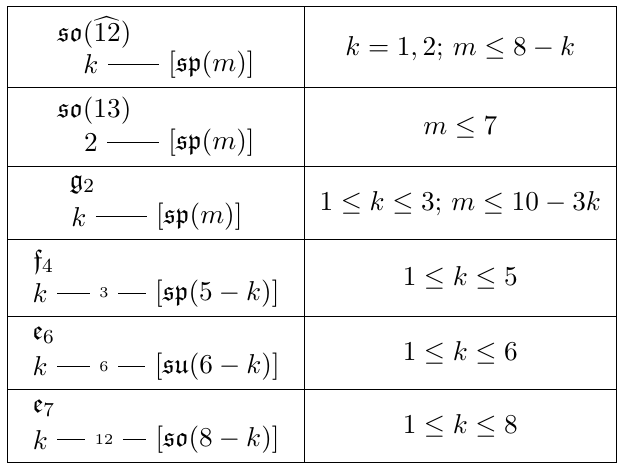
Table 2 . Continuation of table